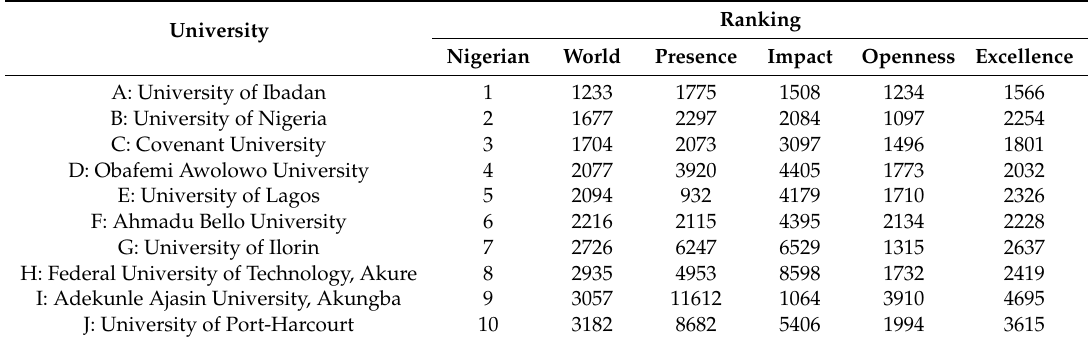
Table 1. Ranking of some of the best universities in Nigeria (Webometrics